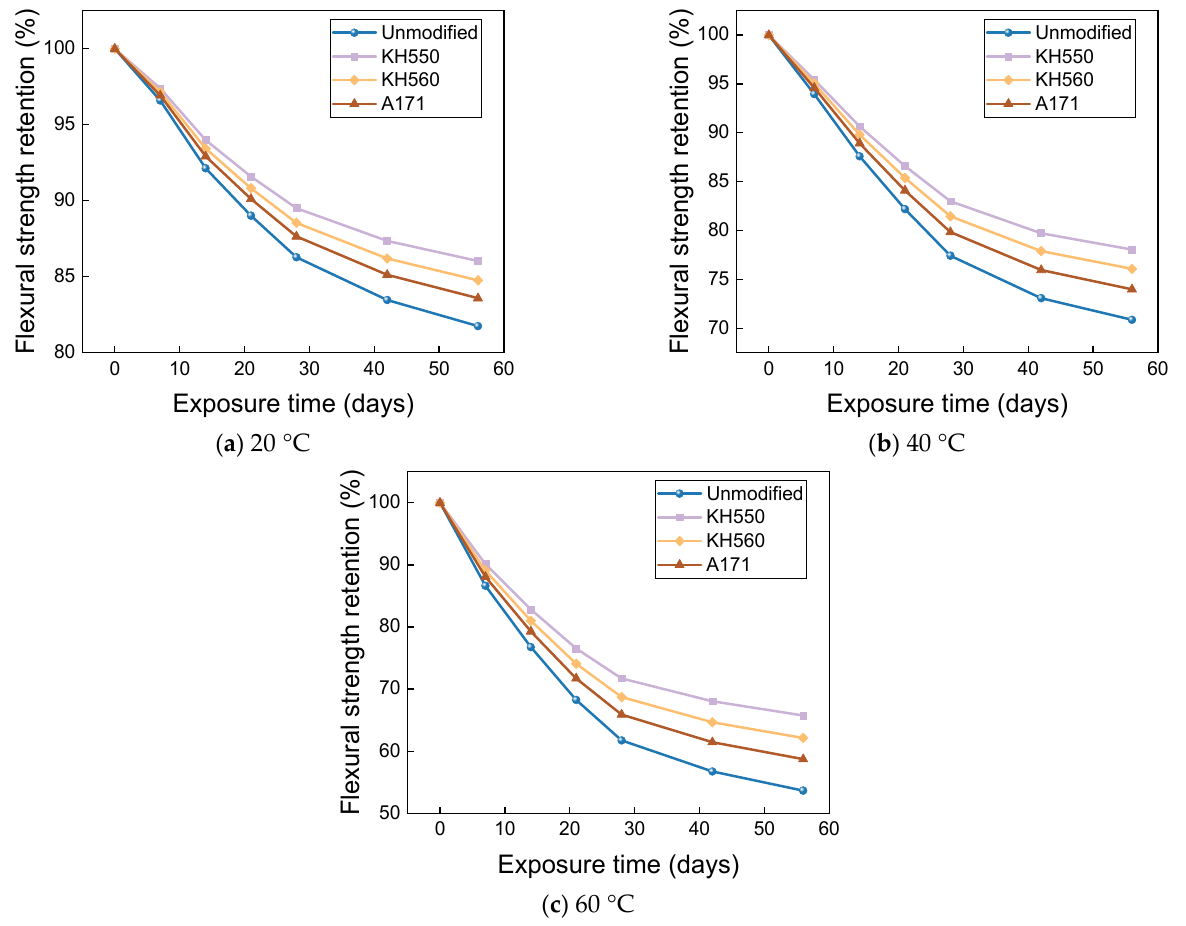
Figure 26. Flexural strength retention in a 10% H 2 SO 4 acidic environment. Hydrolysis of resin matrix under acidic